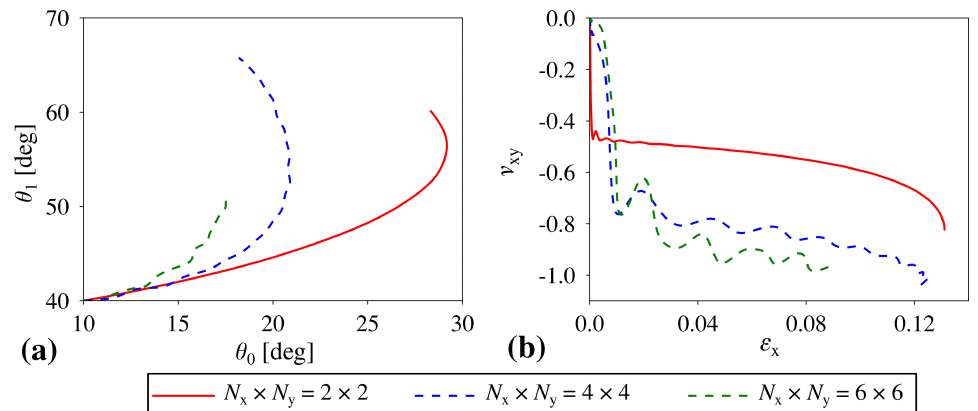
Figure 5. The effect of the variation in the number of squares constituting level 1 building blocks on the behaviour of the structure. These results were generated for structures where all off the hinges corresponded to the same stiffness coefficient equal to 0.2 K hL . ( a ) the dependence of θ 1 vs. θ 0 during the deformation process and ( b ) the variation in the Poisson’s ratio for loading in the x -direction plotted against